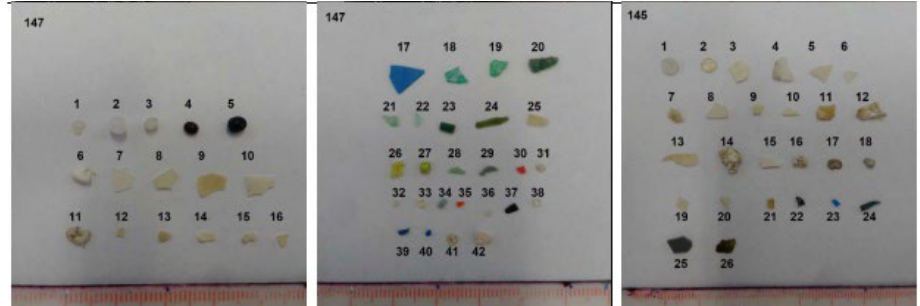
Figure 3. Representative picture of some of the analyzed plastic debris.